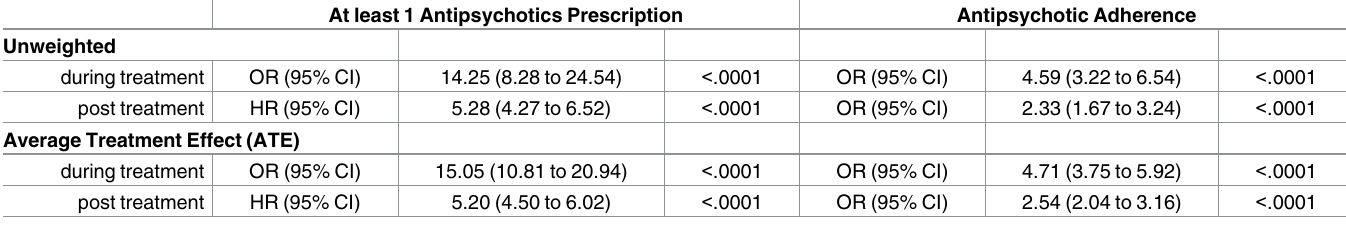
Table 5. Effect of EPPIS treatment on receiving outpatient medications and medication